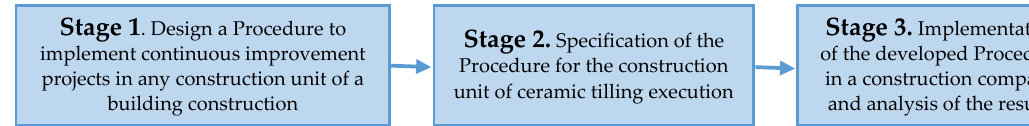
Figure 1. Scheme of the methodology.